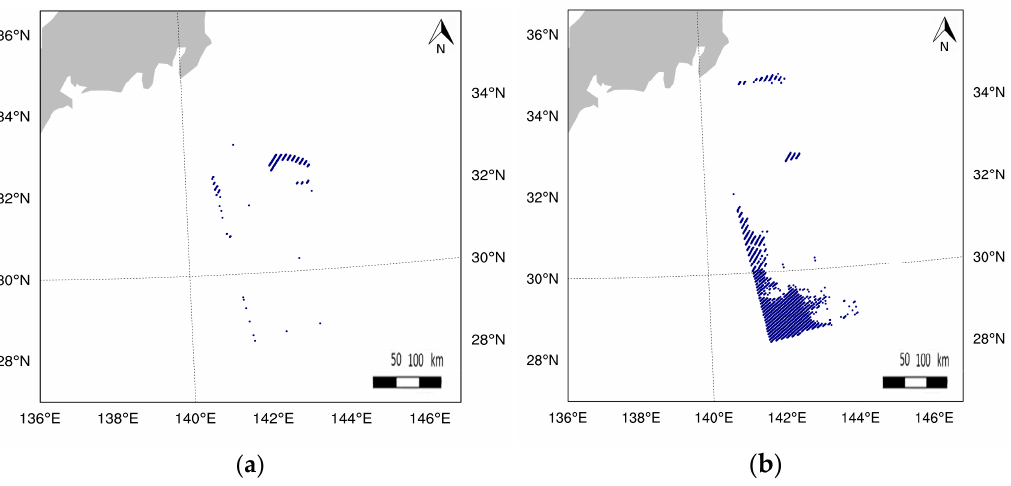
Table 3. Details of the three experiments.